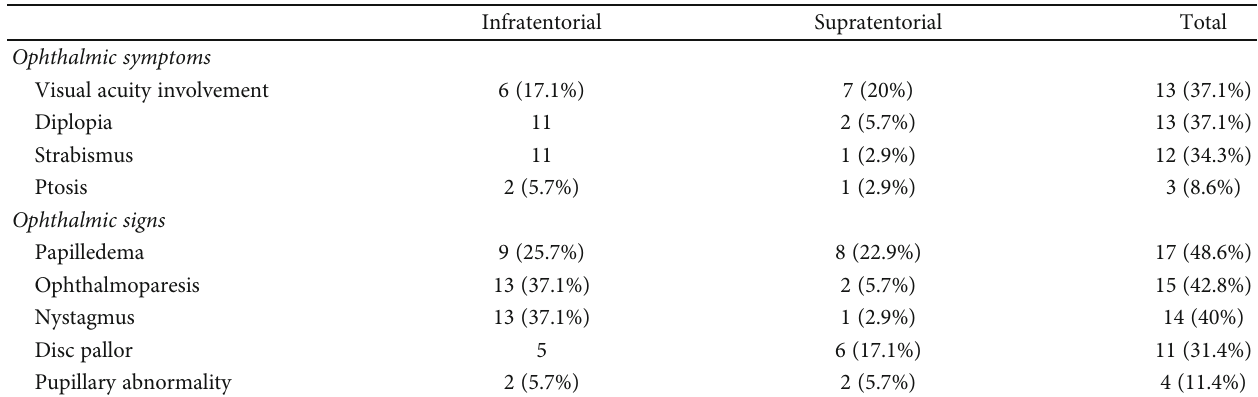
Table 2: Ophthalmic manifestations of the tumours according to infratentorial location and supratentorial location of the tumour.